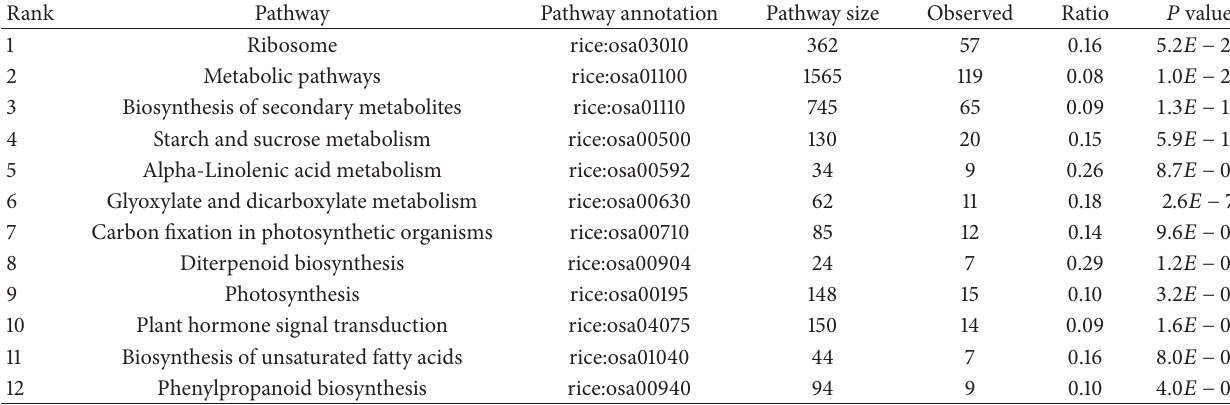
Table 2: Top ranked pathways that are regulated (1374 genes) at 25 ∘ C by KEGG analysis.